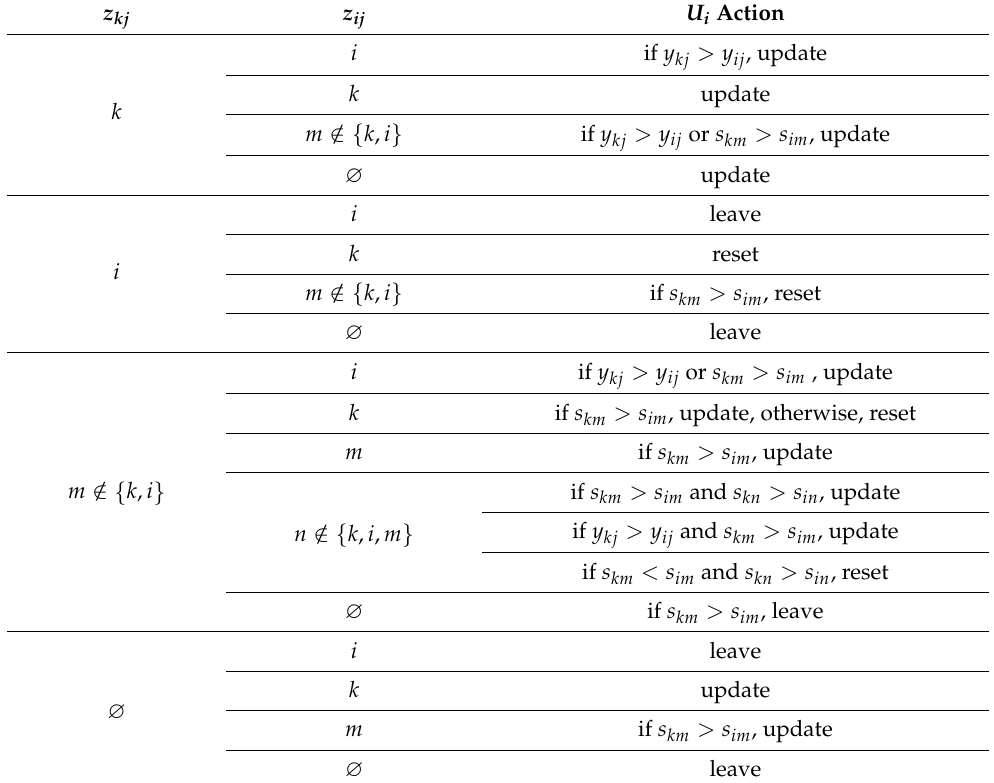
Table 1. Conflict resolution